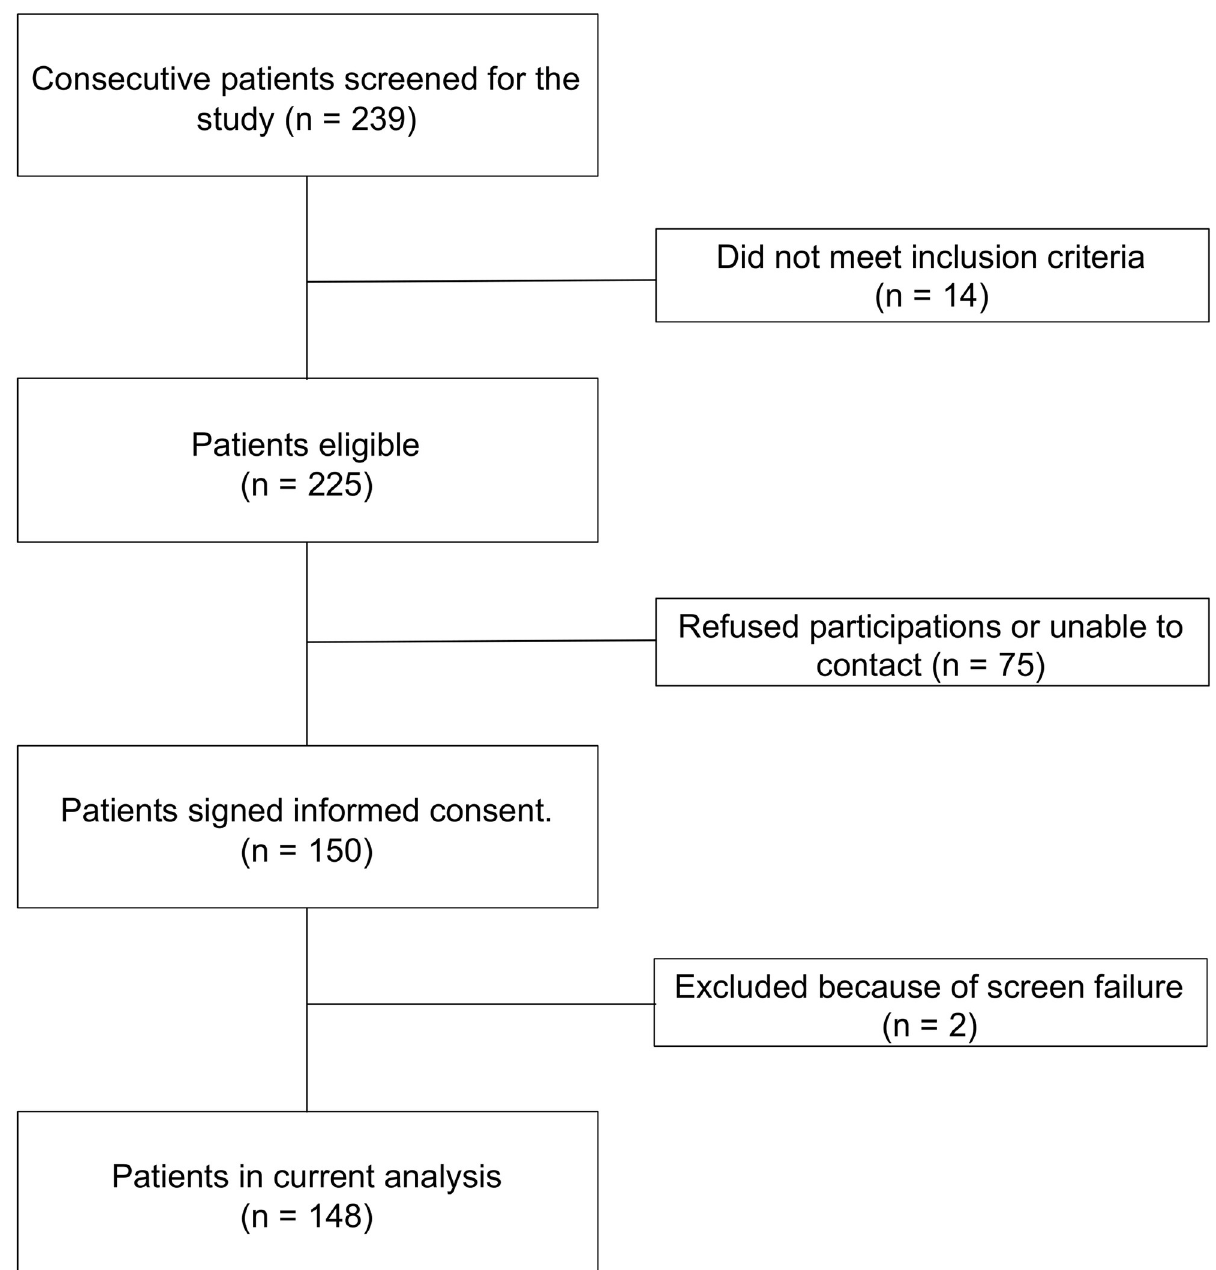
Fig 1. Flowchart of patient selection